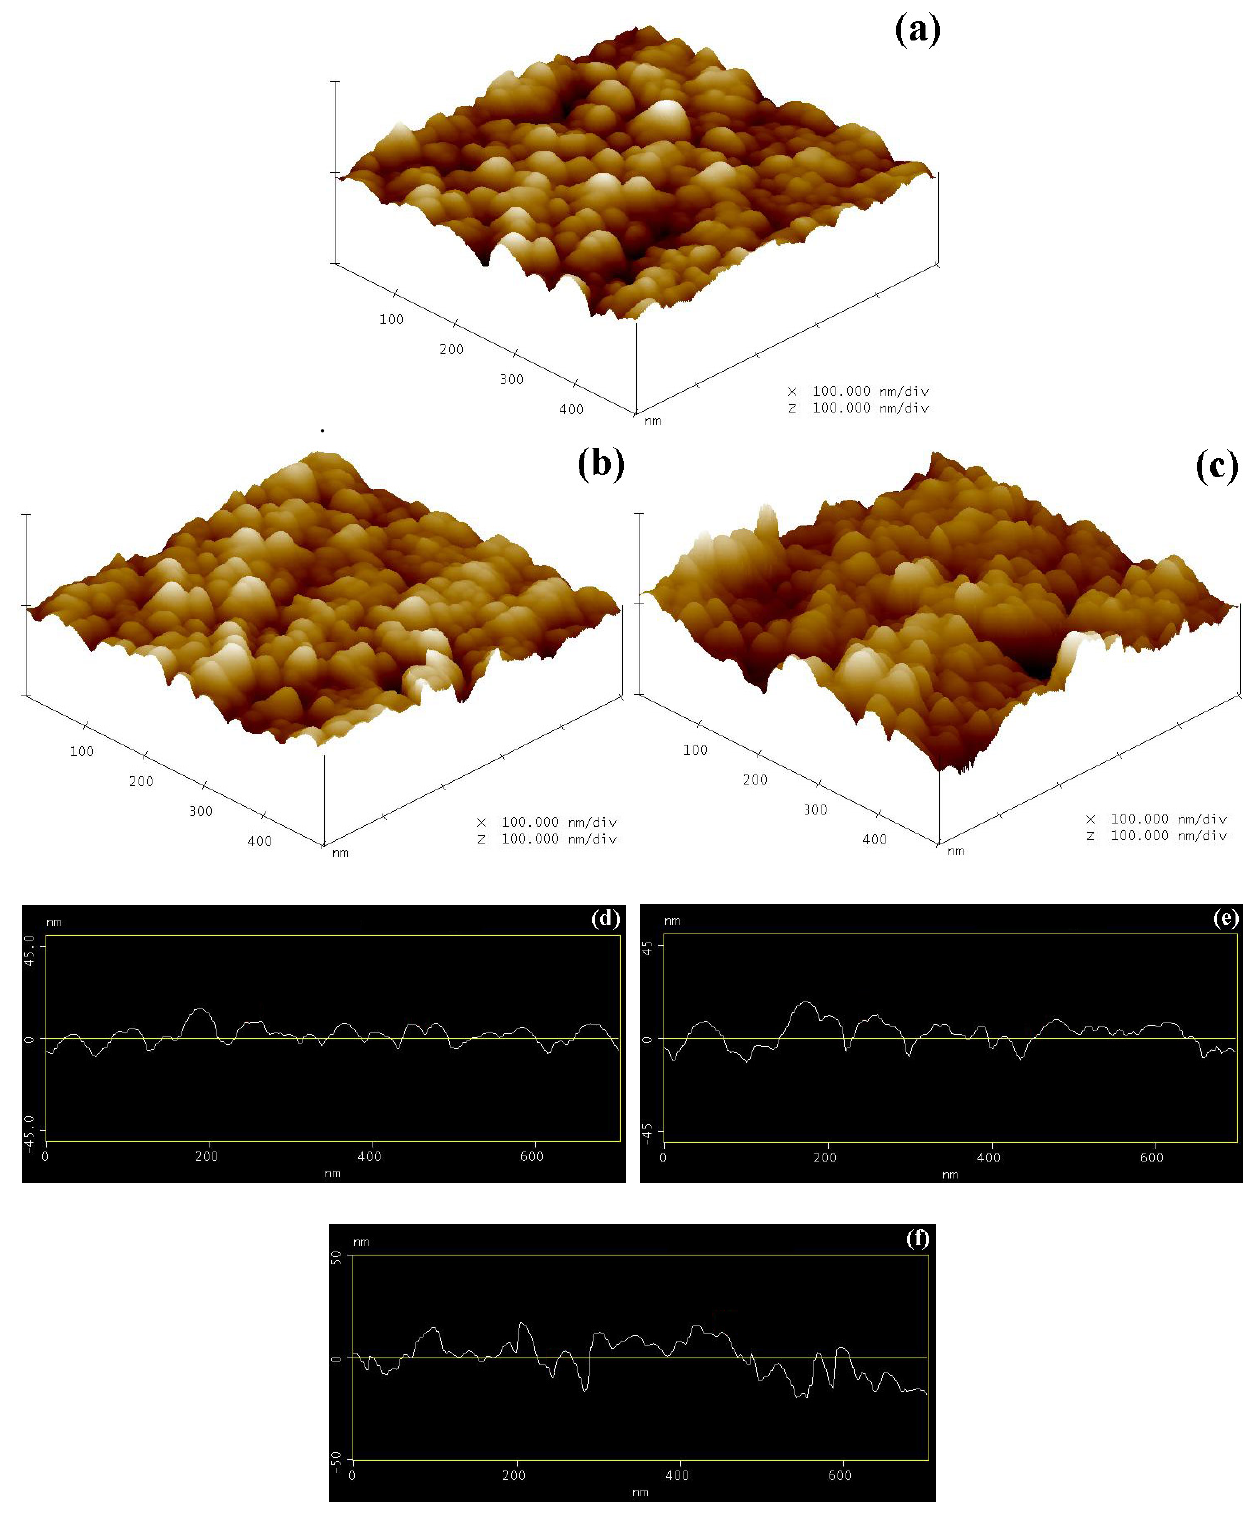
Figure 5. AFM micrographs of (a) pure, (b) 1 mol%, and (c) 5 mol% Pd-doped ZnO nanoparticles. The sectional analysis of surface roughness profiles of (d) pure, (e) 1 mol%, and (f) 5 mol% Pd-doped ZnO nanoparticles.